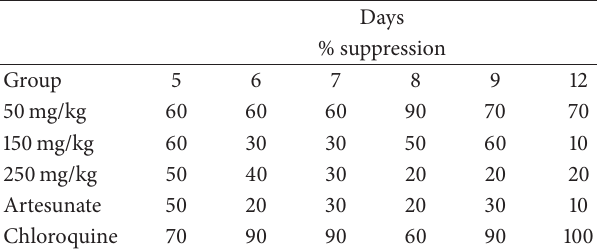
Chloroquine 28 Table 4: Percentage chemosuppression of parasitaemia by the aqueous root extract of L. cupanioides and standard drugs. Days %